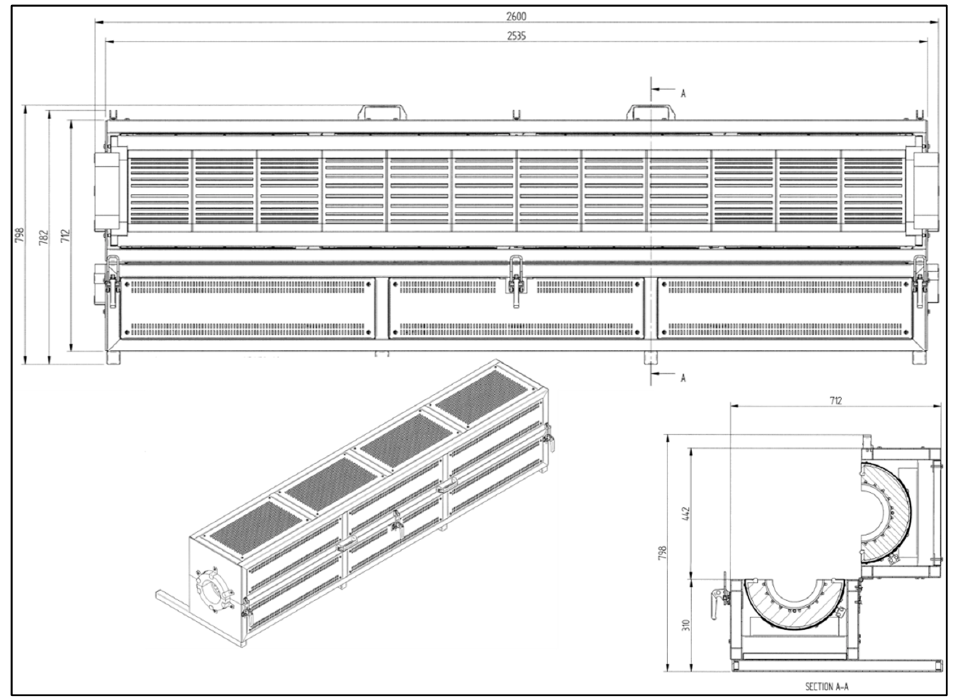
Figure 2. Drawing of 3-zone furnace with dimensions (mm) (Source: Carbolite).